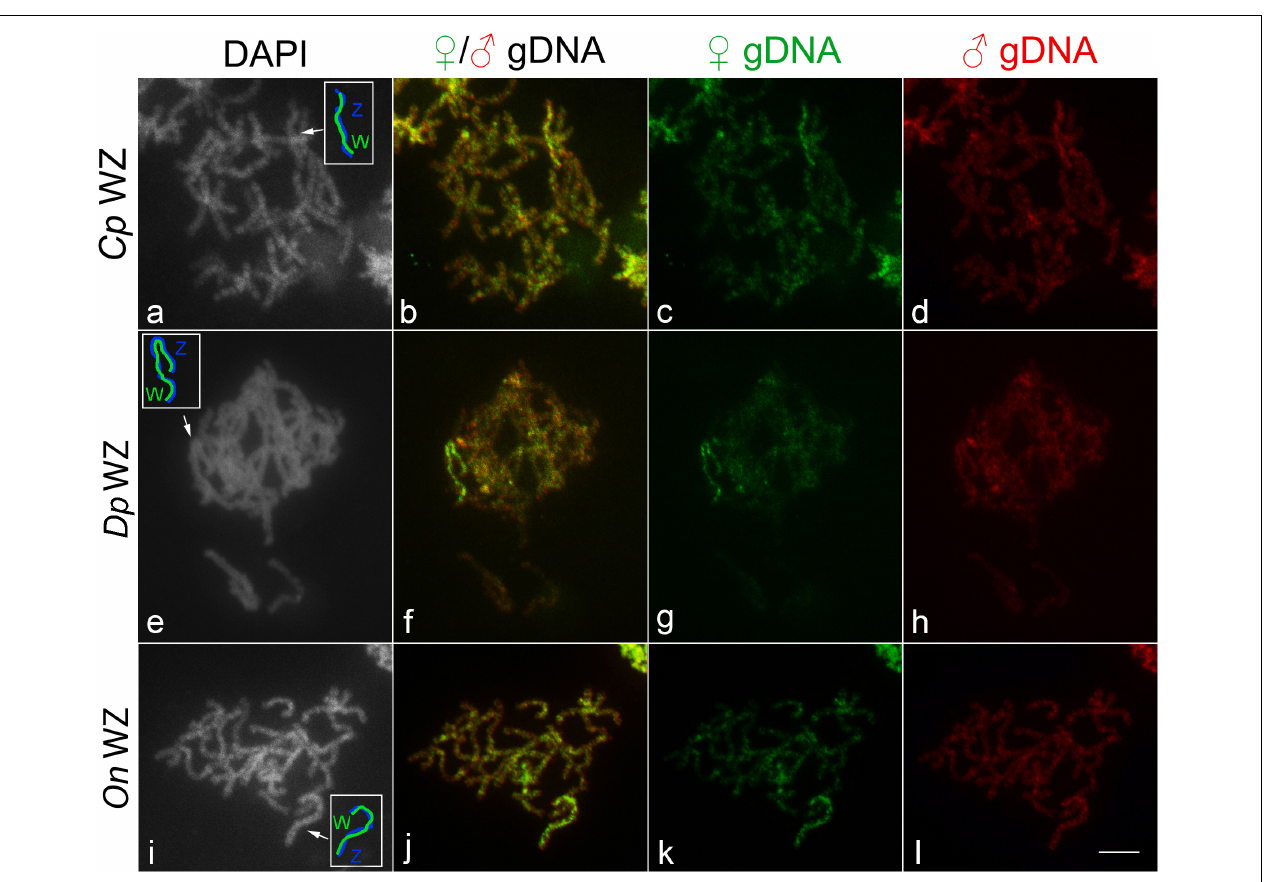
FIGURE 2 | WZ sex chromosome bivalents identified by comparative genomic hybridization (CGH) in female pachytene oocytes of (a–d) Cydalima perspectalis , (e–h) Diatraea postlineella , and (i–l) Ostrinia nubilalis . (a,e,i) DAPI staining, (b,f,j) merged images of male-derived and female-derived probes, (c,g,k) female-derived genomic DNA probe, and (d,h,l) male-derived genomic DNA probe. Sex chromosome bivalents are indicated by arrows and schematized in white boxes in panels (a,e,i) . Bar = 10 µ